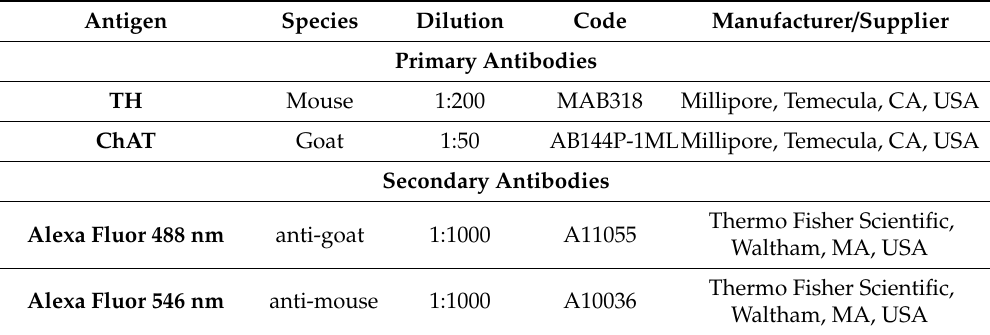
Table 1. Description of